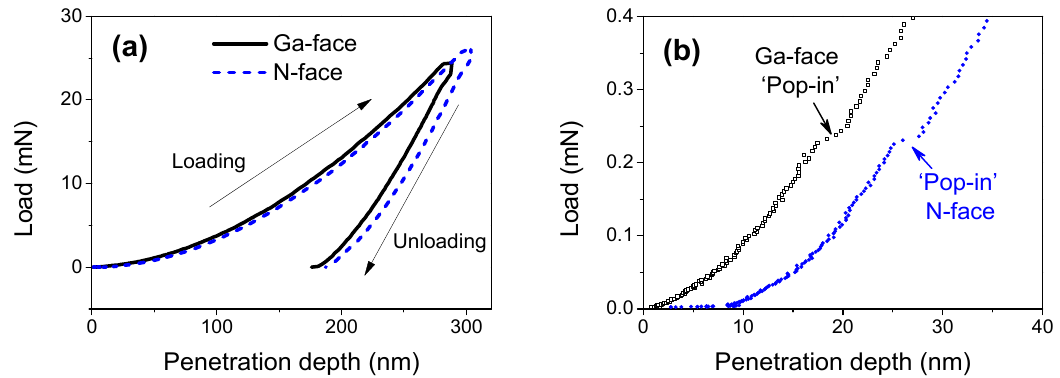
Figure 2. Nanoindentation tests on Ga- and N-faced GaN samples. ( a ) Loading and unloading curves of nanoindentation; ( b ) ‘Pop-in’ phenomena during the initial loading stage.